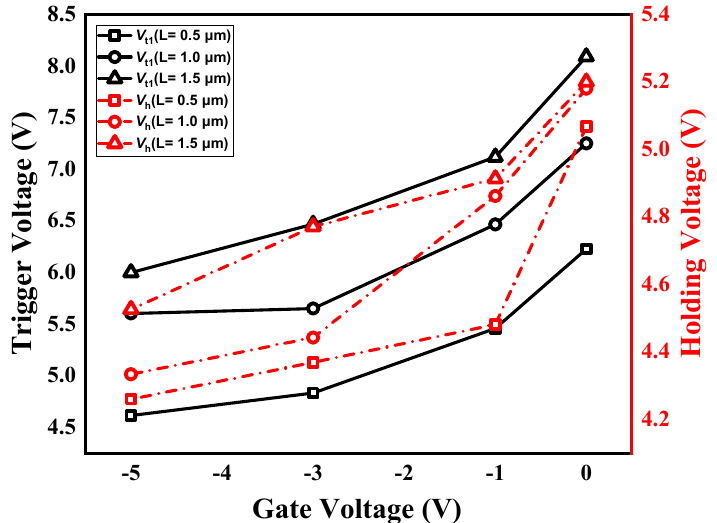
Figure 7. Measured trigger voltage and holding voltage of PTBSCR with different L versus different gate voltages.